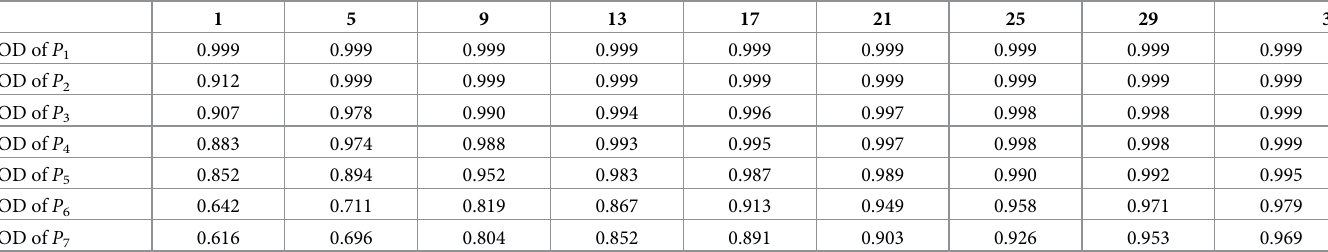
Table 1. The degrees of approximation (OD) of different shapes at designated interceptive values.